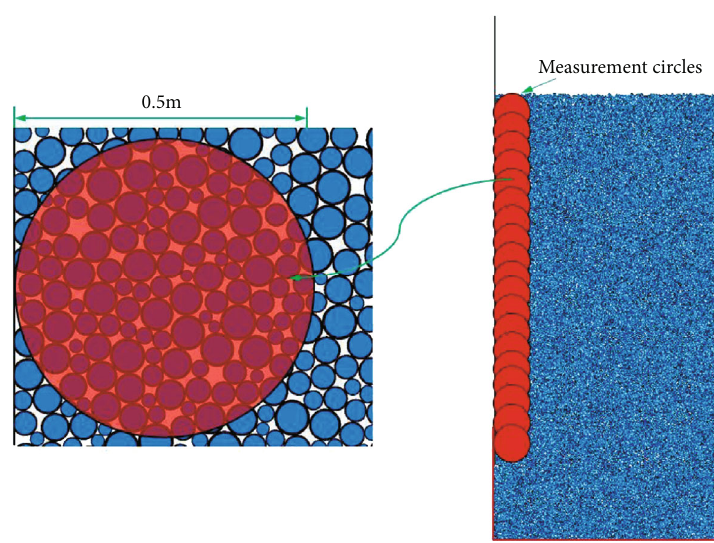
Figure 11: Layout of measuring